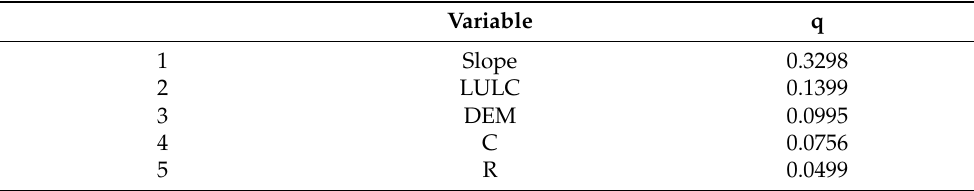
Table 9. Detection of SE factors in the QLB from 1990 to 2020.